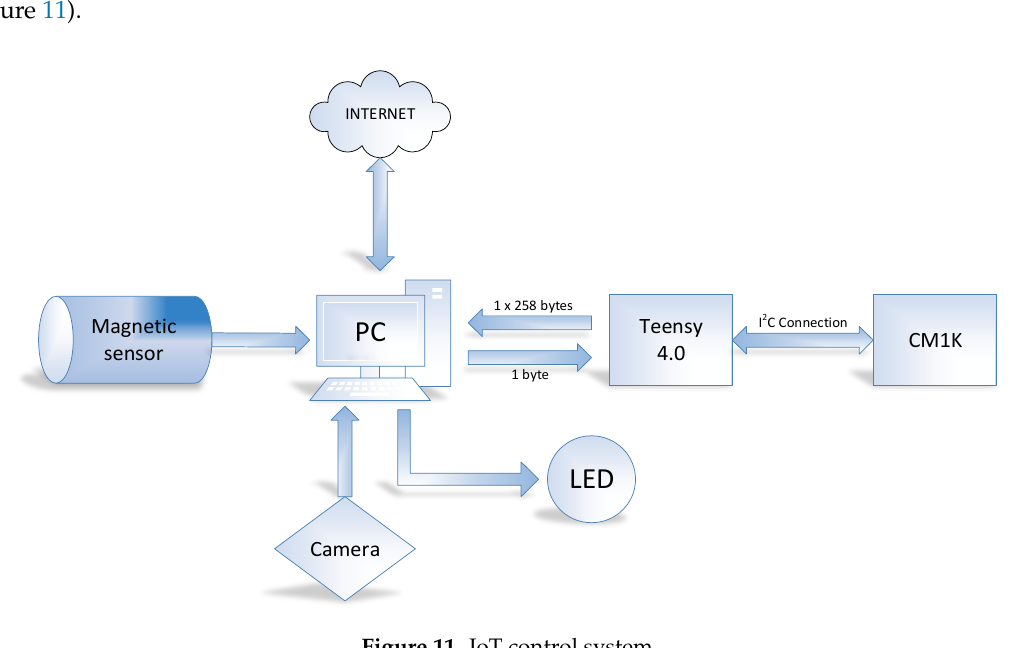
Figure 11. IoT control system.